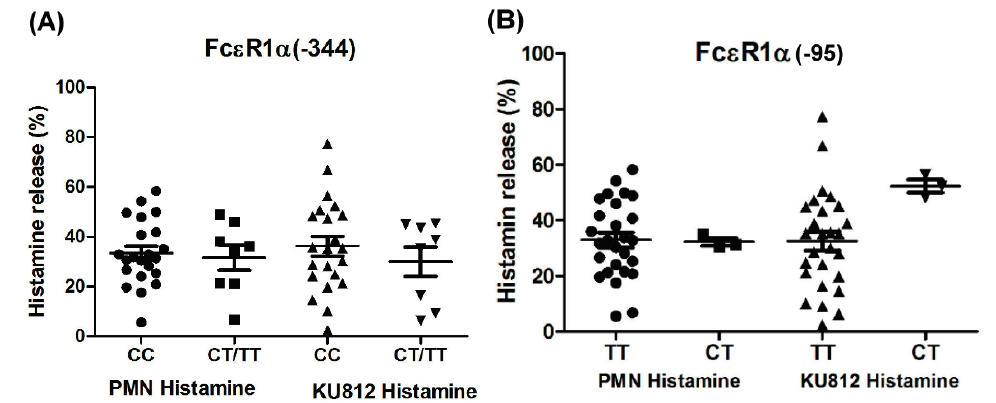
Figure 3. Genetic effect of SNPs of the Fc ε R1 α promoter region on histamine release. The PMNs derived from patients with different Fc ε R1 α promoter SNPs and KU812 cells-presensitized with serum were incubated with Der p2 for 30 min, followed by histamine analysis. Values were presented as mean ± SEM. The results obtained from ( A ) genotype of Fc ε R1 α ( − 344CC, CT/TT) and ( B ) genotype of Fc ε R1 α ( − 95TT,